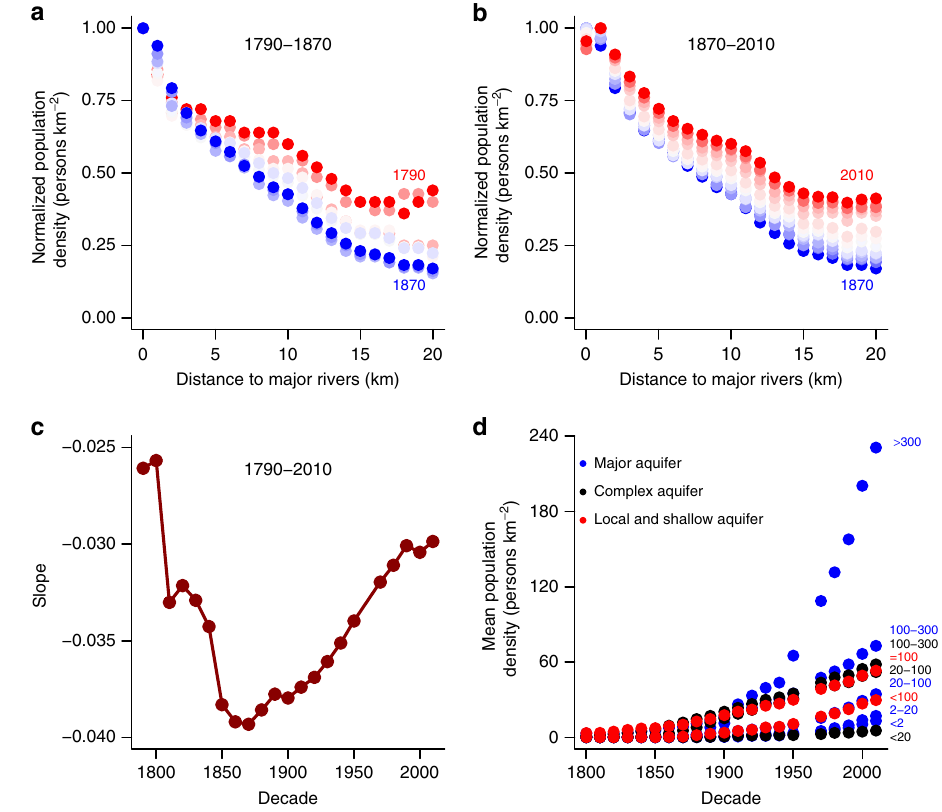
Fig. 3 The dynamic human population distance to water. The relationship between normalized population density (NPD) and distance to major rivers (DMR) in the conterminous US from a 1790 to 1870 and b 1870 to 2010. c The changing desirability of living close to major rivers, re fl ected in the slope of NPD vs. DMR. d Mean population density overlying each aquifer type from 1790 to 2010. Recharge rates, mm per year, are shown offset. We use the red- to-blue gradient to indicate the trend for the decades to 1870 in a and the gradient from blue to red for decades from 1870 in b . The data points for a , b are based on DMR classes while those for c and d are based on census